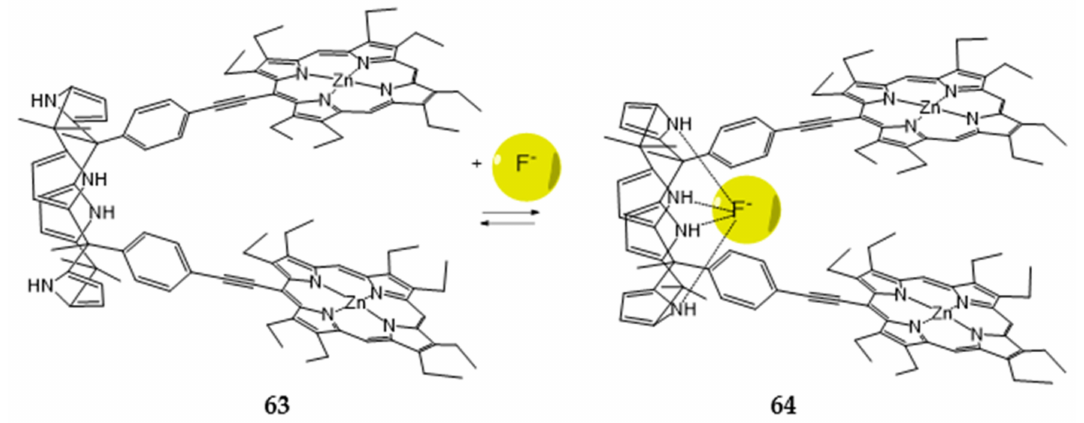
Scheme 18. 1:1 complexation of the receptor 63 with F −